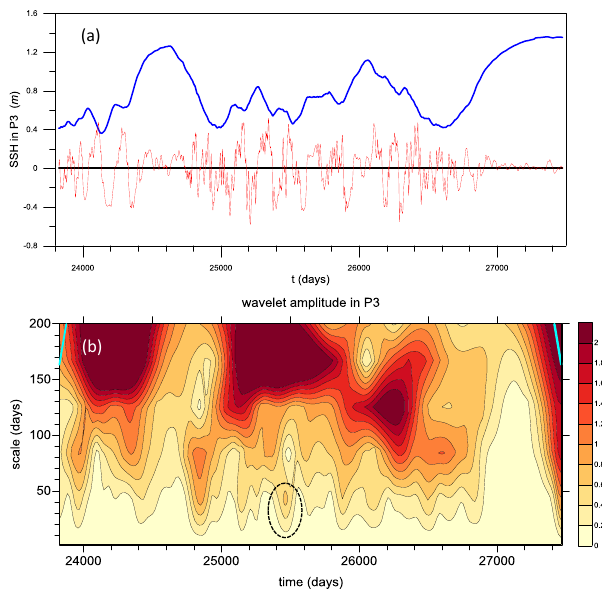
Fig. 13. (a) Low-frequency SSH at P3 (blue line) and corre- sponding high-frequency residual (red line) for the reference inter- val. (b) Wavelet amplitude of the SSH signal for the same point and time interval (the cyan lines indicate the cone of